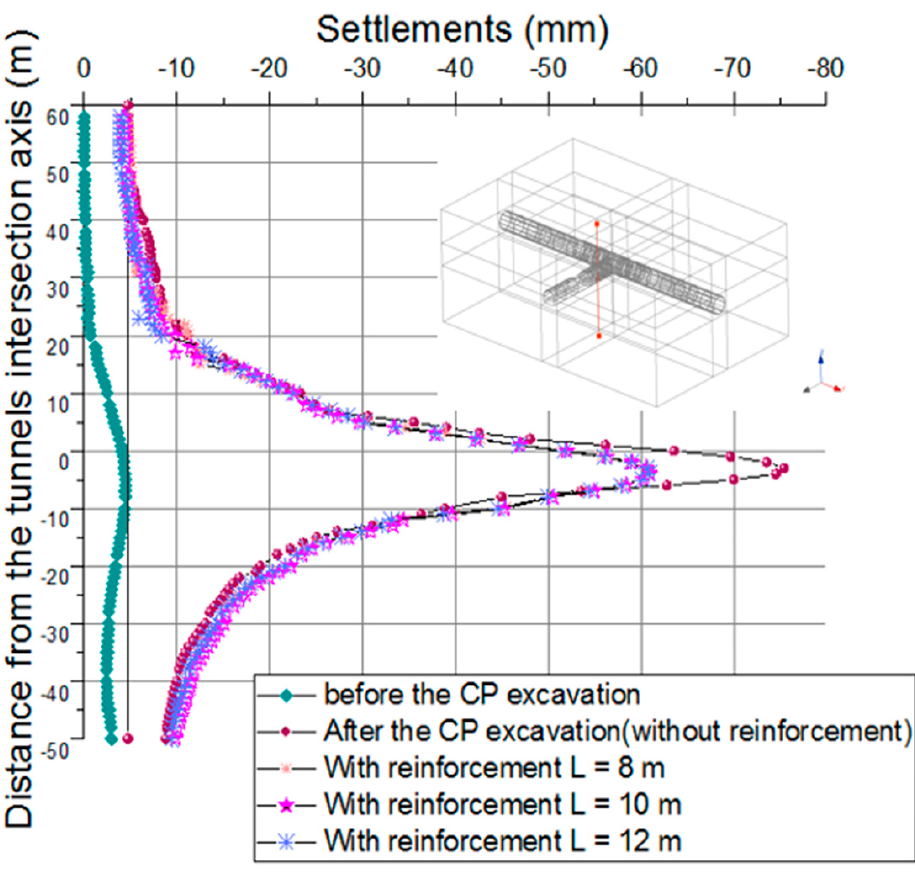
Figure 6. Effect of umbrella arch technique on face extrusion.